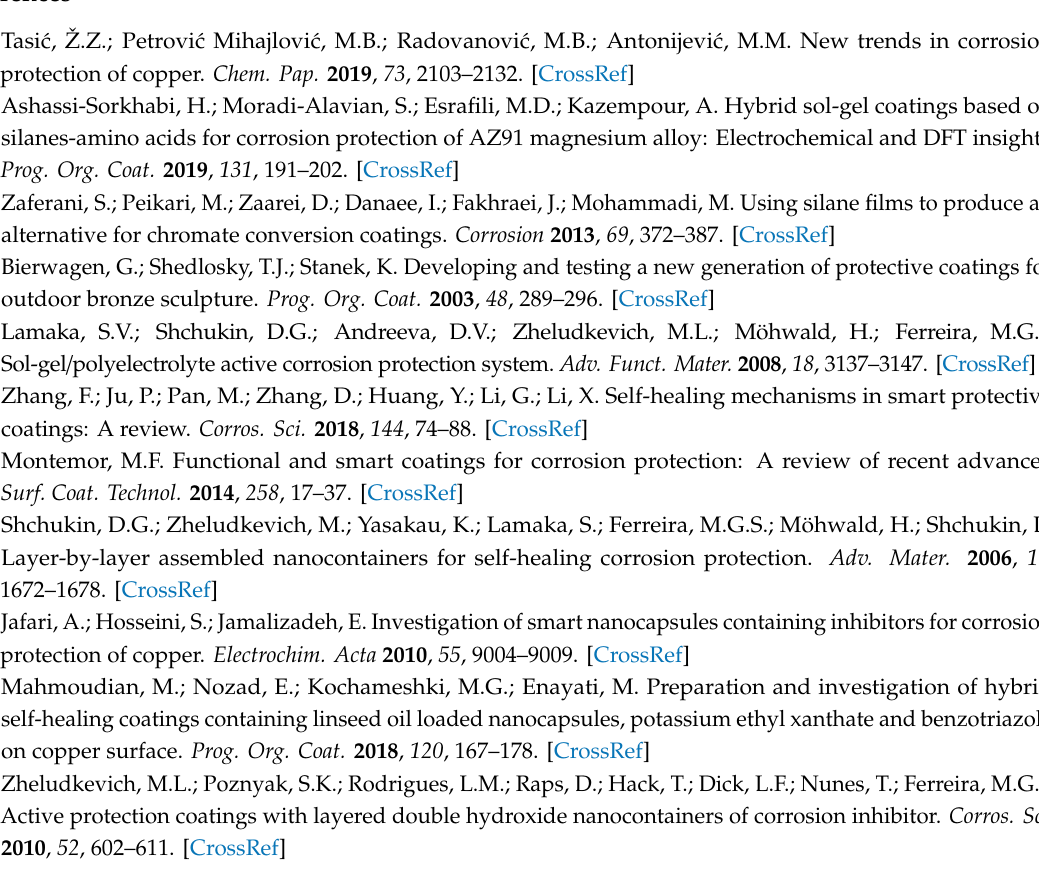
Table S1, Figure S2: Stacked plot and computational analysis of the DOSY experiment of a sample containing MPT alone. MPT signal decays according to the gradients (G) together with the corresponding graphical analysis of the data. The di ff usion coe ffi cients are indicated with the letter F, Figure S3. Stacked plot and computational analysis of the DOSY experiment of a sample containing MPT + β -CD. MPT signal decays according to the gradients (G) together with the corresponding graphical analysis of the data. The di ff usion coe ffi cients are indicated with the letter F, Figure S4: Stacked plot and computational analysis of the DOSY experiment of a sample containing MPT + β -CD. β -CD signal decays according to the gradients (G) together with the corresponding graphical analysis of the